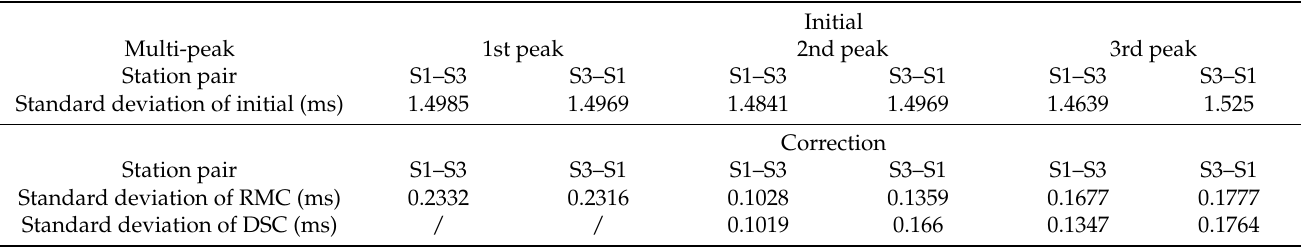
Table 1. Standard deviation comparison of initial and correction travel